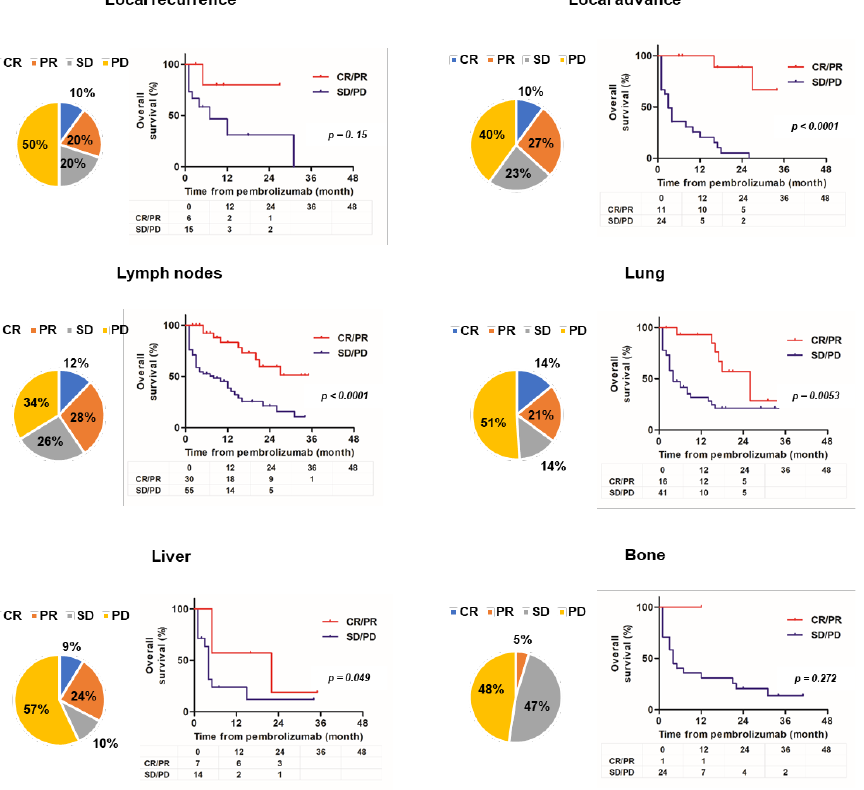
Figure 2. Organ-specific objective response rate and Kaplan–Meier curves comparing responder and non-responder groups. The pie chart presents the best response for each lesion and the Kaplan– Meier estimates of overall survival compared to responders or non-responders for each lesion (local recurrence, local advance, lymph node, lung, liver, and bone). Six unresectable and metastatic sites of local recurrence; local advance; and lymph node, lung, liver, and bone metastases are shown. Because of the small number of meta- static cases, metastatic sites in the brain, pleura, peritoneum, and other locations were ex- cluded. For lesion sites other than bones, the organ-specific ORR was 30–40%, but the ORR for bone metastasis was only 5%. There was no significant difference in OS between re- sponders and non-responders with local recurrence and bone metastasis metastases (haz- ard ratio (HR) 2.86 (0.67–12.3), p = 0.15; HR 3.44 (0.38–31.1), p = 0.27, respectively). How- ever, there was a significant difference in OS between responders and non-responders with locally advanced lesions and lymph node, lung, or liver metastases (HR 9.02 (3.63– 22.4), p < 0.0001; HR 3.63 (1.97–6.69), p < 0.0001; HR 2.75 (1.35–5.59), p = 0.0053; HR 3.17, (1.00–10.0), p = 0.049, respectively). Figure 3 shows the change in organ-specific ORR over time. A relatively long-term response was observed in local lesions and lymph node me- tastases, but a short-term response was observed in lung and liver metastases. In other words, lung and liver metastases tend to become refractory, even if an effect is initially observed. Supplementary Table S1 shows the univariate and multivariate analyses of background factors for OS. Univariate analysis revealed that ECOG–PS ≥ 2, liver metasta- sis, and bone metastasis were statistically significant poor prognostic factors for OS (HR 5.53 (2.20–13.9), p = 0.0003; HR 2.16 (1.08–4.31), p = 0.030; HR 2.36 (1.23–4.55), p = 0.010, respectively). Multivariate analysis revealed that ECOG–PS ≥ 2 was an independent prog- nostic factor for OS (HR 2.29 (1.20–4.36), p = 0.012).